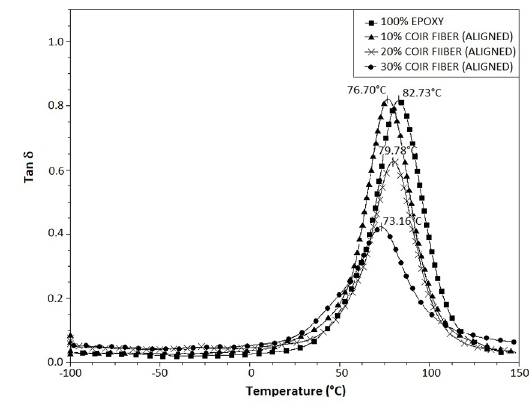
Figure 6. Damping curves for the epoxy reinforced with different volume fractions of aligned coir